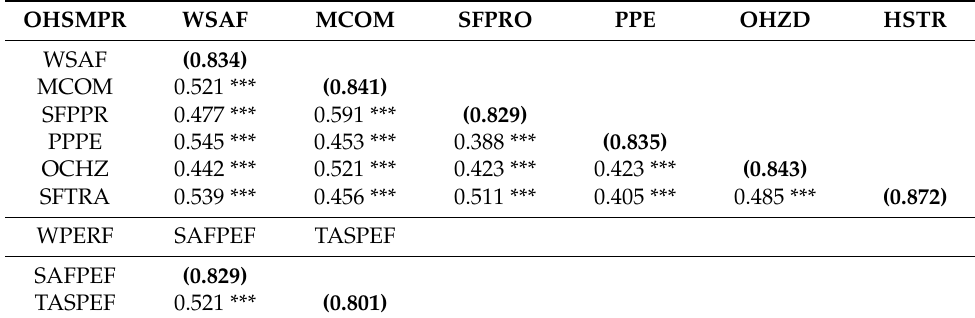
Table 6. Results of Discriminant Validity.